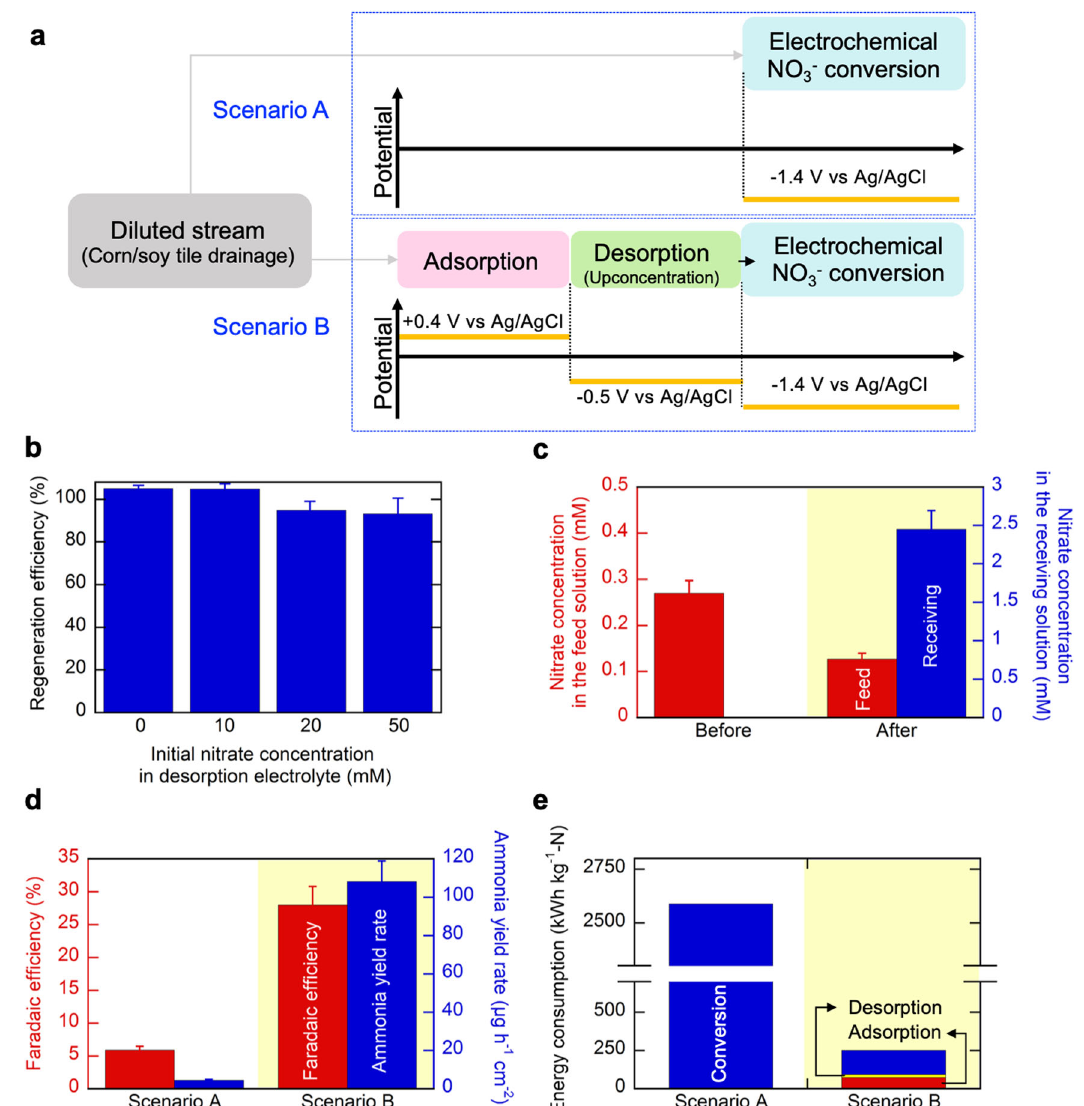
Fig.7|Integrationofseparation,up-concentration,andconversionandenergy analysis. a A schematic illustration of two scenarios for treating a dilute nitrate stream (corn/soy tile drainage sample collected from the University of Illinois Energy Farm). In scenario A, an electrocatalyst directly electrocatalyzes the dilute nitrate feed. In scenario B, to overcome the low nitrate concentration and con- ductivity, a full cycle of adsorption and regeneration was performed to generate up-concentrated, localized nitrate stream, which then can be electrocatalyzed by the same electrode. All the operation can be done in one device, solely by con- trolling electrode potential. b Regeneration ef fi ciency (nitrate recovered/nitrate